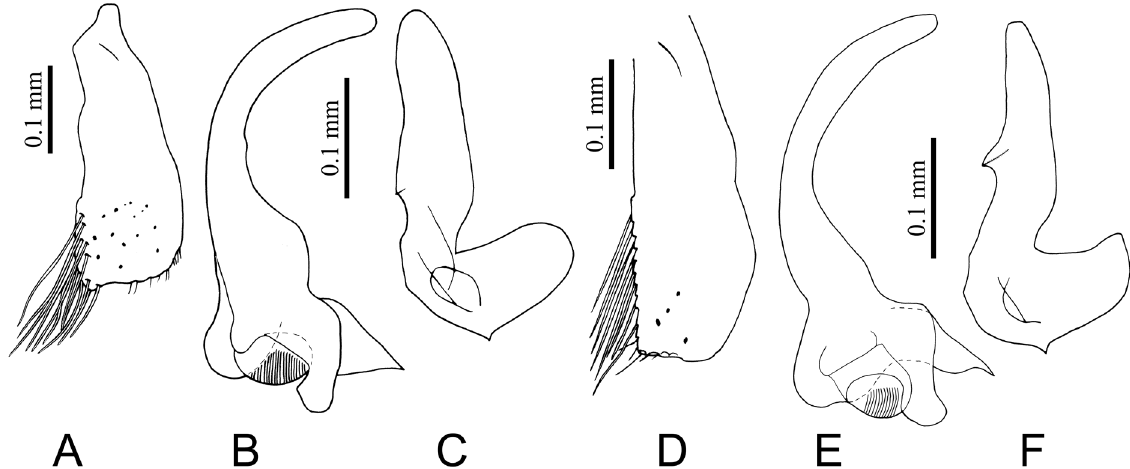
Fig. 7. Morphological features of species of Micronecta Kirkaldy, 1897, ♂♂. A–C . M . drepani Nieser, 2000 (ZVNU). D–F . M. erythra Nieser, Chen & Yang, 2005 (ZVNU). A, D = free lobe; B, E = right paramere; C, F = left